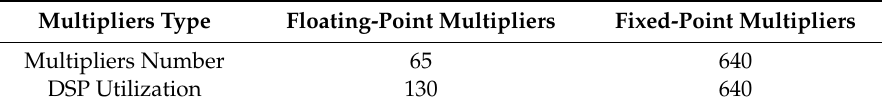
Table 2. The details of Digital Signal Processing (DSP) utilization in our architecture.